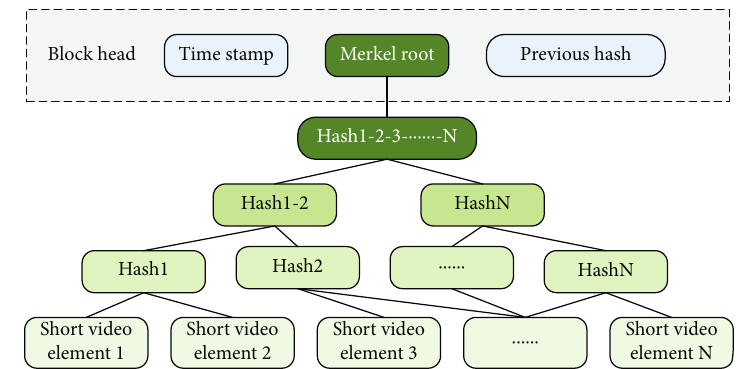
Figure 8: Calculating Merkel root value of